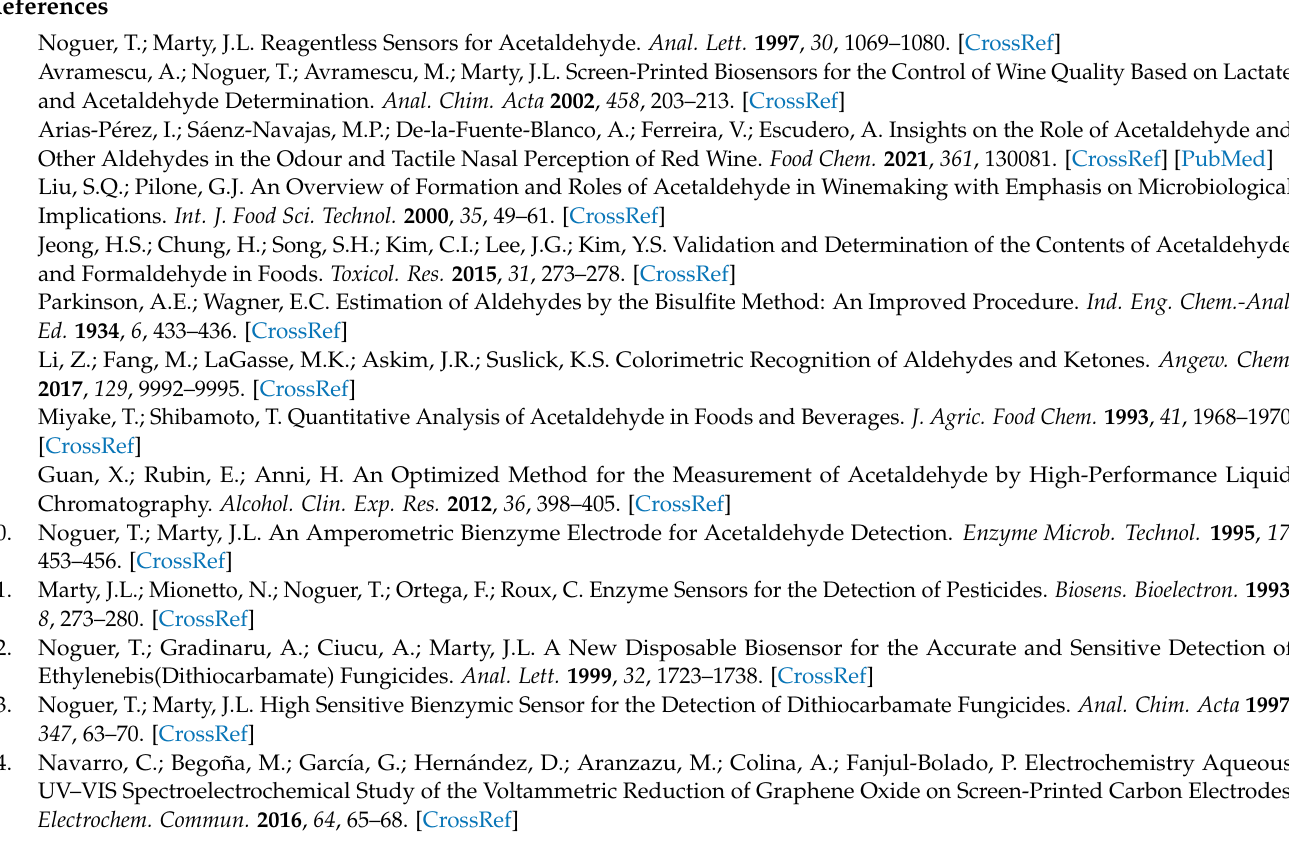
KCl buffer solution (pH 8). Figure S3: Chronoamperograms obtained applying +0.40 V for 60 s with different dilutions of ros é and white wines, ALDH, DP, NAD + , K 3 [Fe(CN) 6 ] and BSA in phosphate and KCl buffer solution (pH 8). Figure S4: UV-vis spectra recorded during the enzymatic reaction (10 min) in AA, ALDH, DP, NAD + , K 3 [Fe(CN) 6 ] and BSA in phosphate and KCl buffer solution (pH 8). Figure S5: UV-vis spectra obtained after applying +0.40 V for 300 s with different concentrations of AA, ALDH, DP, NAD + , K 3 [Fe(CN) 6 ] and BSA in phosphate and KCl buffer solution (pH